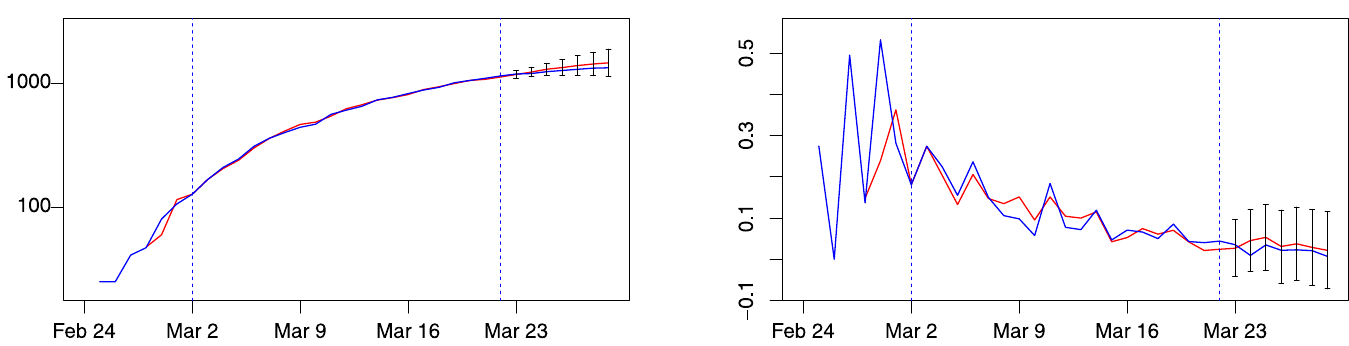
Fig 6. Lombardy forecast for week 5, model d (1, 0). Blue: actual; red: fitted (in estimation sample) or forecast (out-of-sample). Left: number of patients admitted in ICU. Right: % change of patients admitted in ICU. Training sample: February 28–March 22. Out-of-sample period: March 23–29. Forecast intervals ± 3 forecast standard errors.